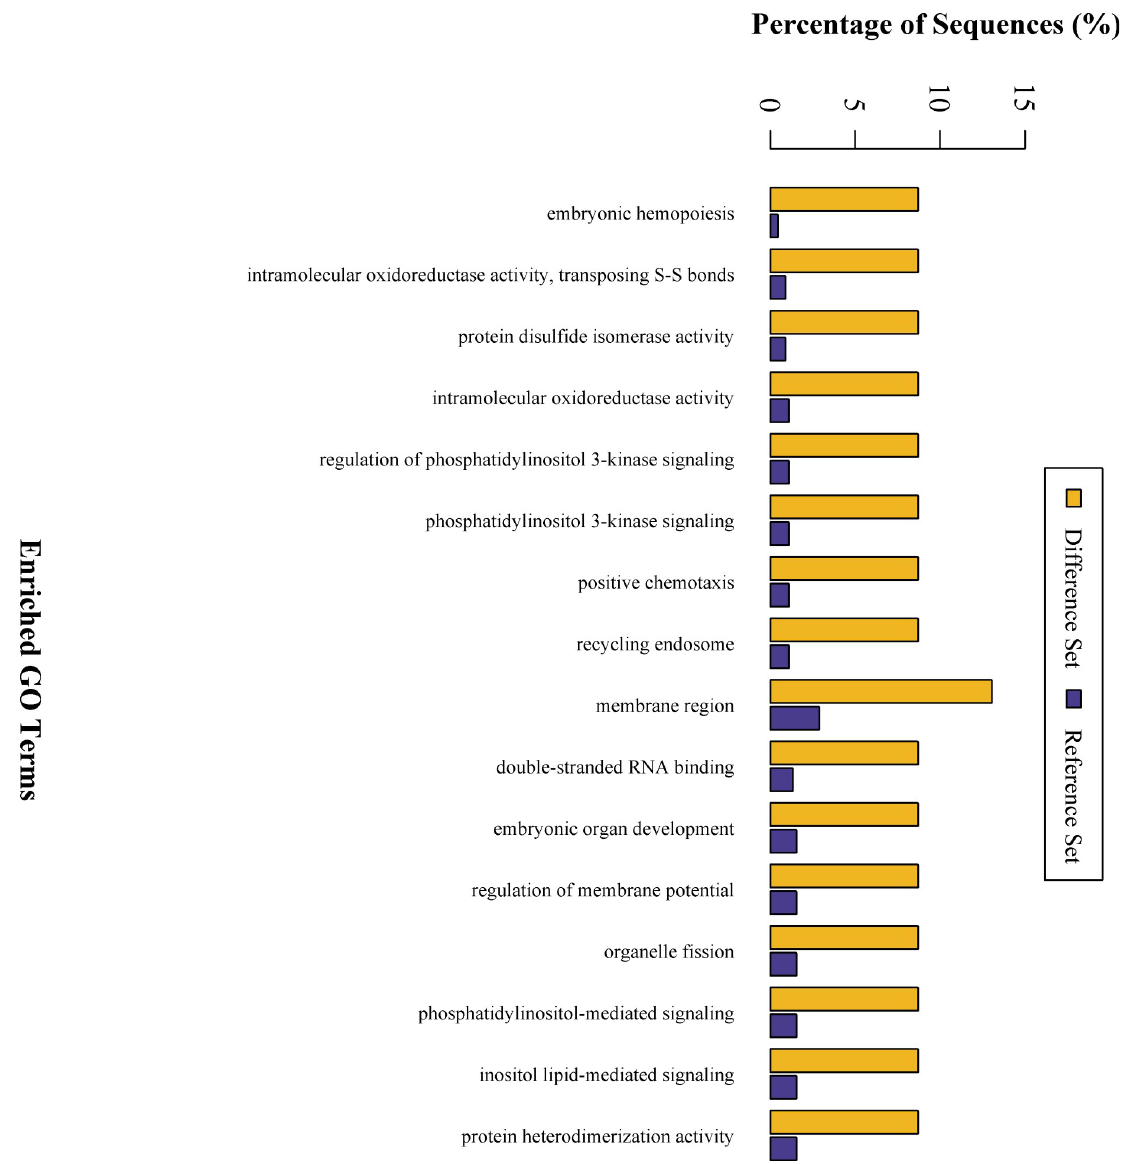
Fig 7. GO enrichment analysis of differential expression proteins. The x axis represents the enrichment GO function whereas the y axis represents the sequence percentage. The yellow bar represents the differential set and the blue bar represents the reference set.